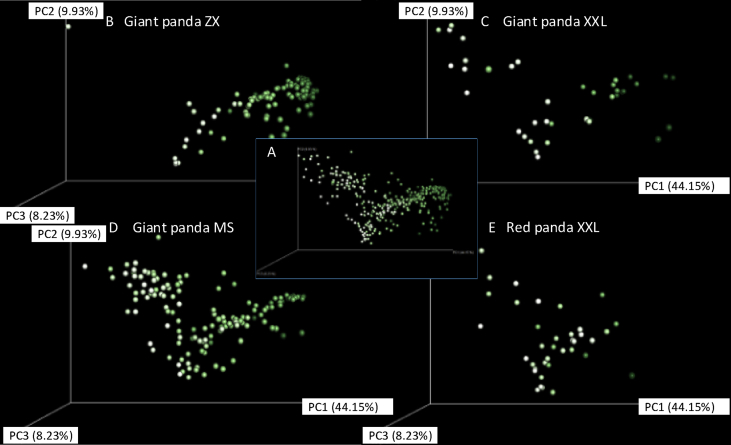
PCoA analysis using Weighted Unifrac distances for panda gut microbiomes: (A) Total pandas, (B) giant panda Zhangxiang ZX, (C) the Xiaoxiangling XXL population, (D), the Minshan MS population and (E), and the Xiaoxiangling red panda population. Each dot represents one fecal sample. Light grey to dark green represents the abundance of Firmicutes from 0.00015 to 0.99396.